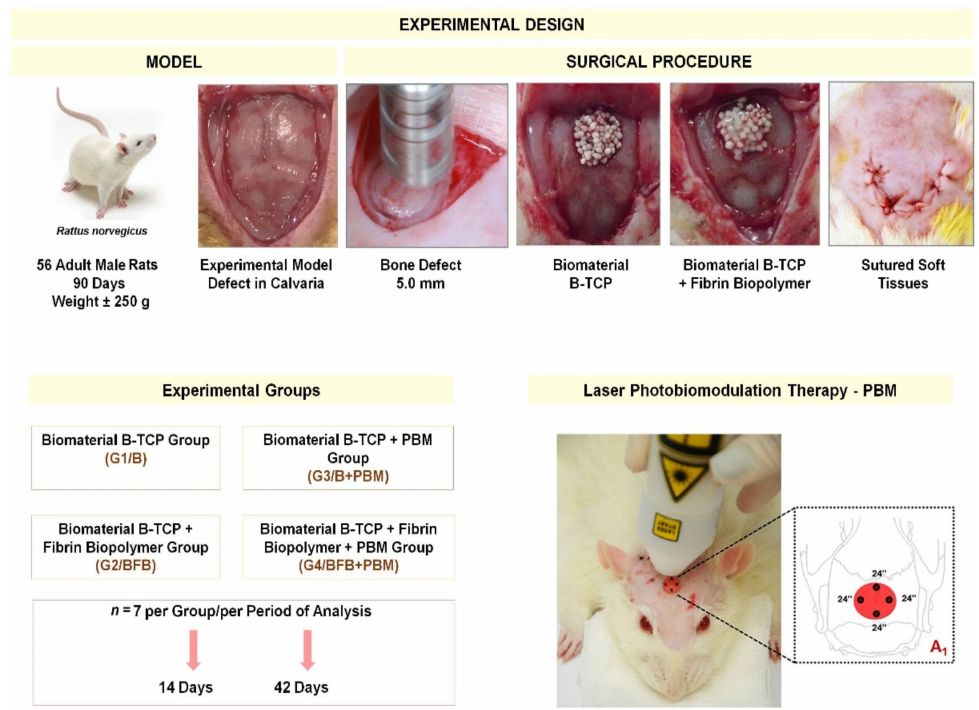
Figure 1. Experimental design. Animal model and inclusion criteria for 56 Wistar male rats ( Rat- tus norvegicus ): adults of 90 days old, weight of approximately ± 250 g; experimental model of bone defect in calvaria, exposure of parietal bones; surgical procedure: fabrication of a 5 mm diameter bone defect with a trephine drill; defect filled with biomaterial BCP (G1/B and G3/B + PBM); defect filled with biomaterial BCP and heterologous fibrin biopolymer (G2/BFB and G4/BFB + PBM); underlying soft tissue repositioned and sutured. A 1 : illustration of post-immediate photobiomodulation (PBM) therapy, followed by 3x per week until the corresponding euthanasia period for the G3/B + PBM and G4/BFB + PBM groups. Experimental periods were 14 and 42 days, with 7